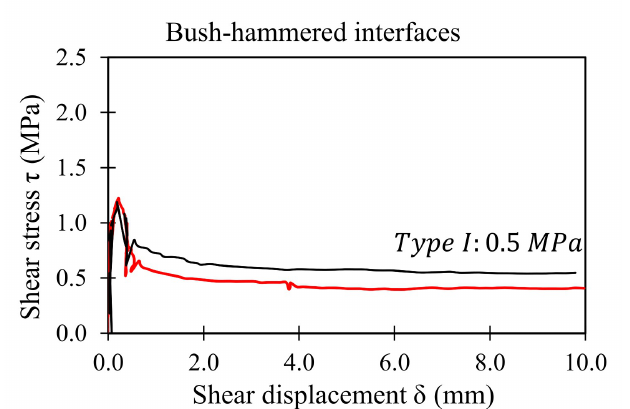
Figure 8. Shear evolution—Type I (bush-hammered interfaces).